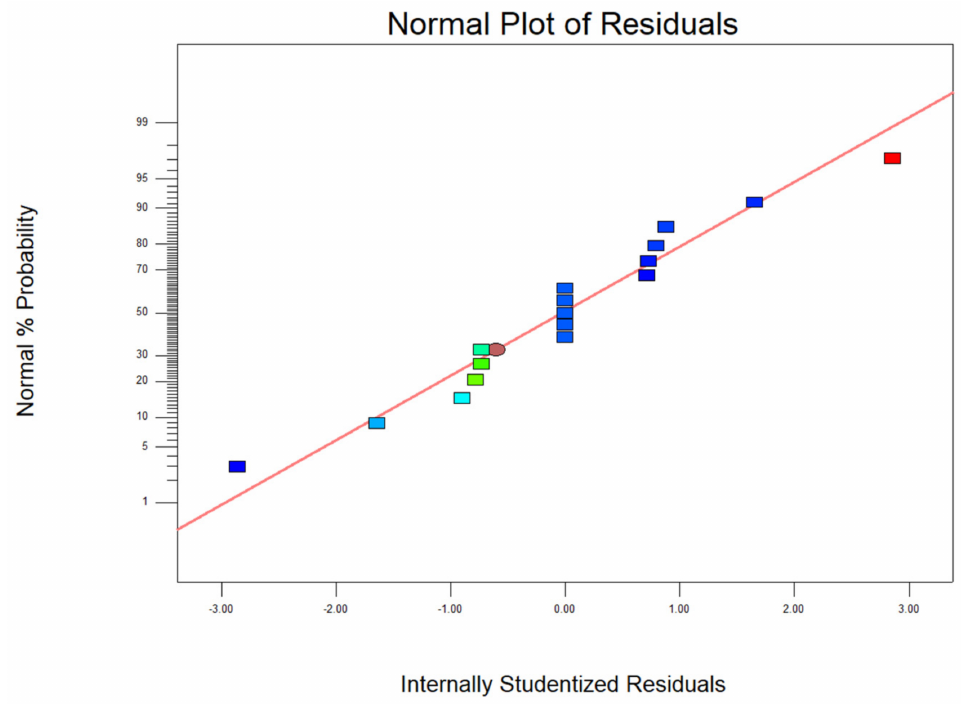
Figure 13. Normal plot of residual